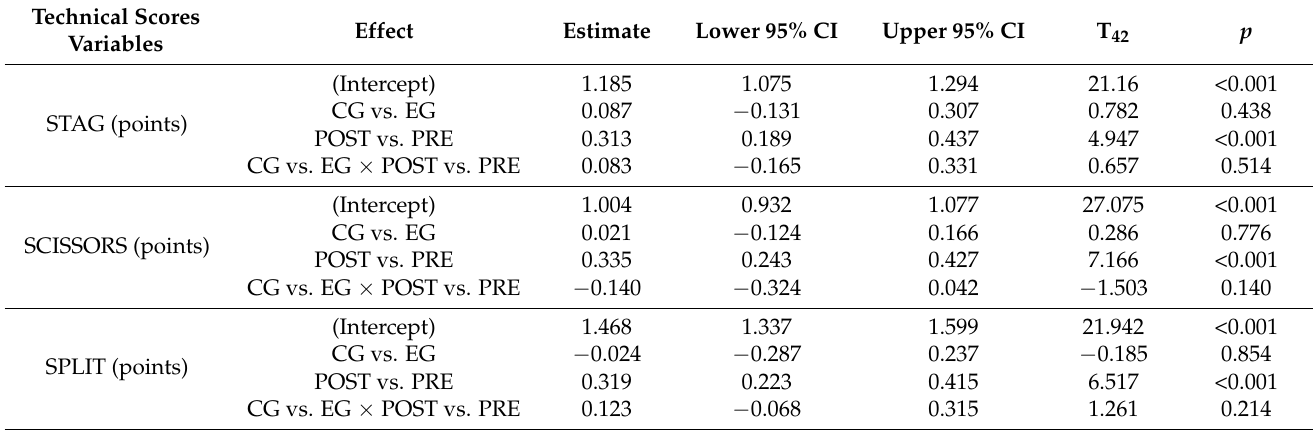
Table 5. Fixed effects of the technical scores’